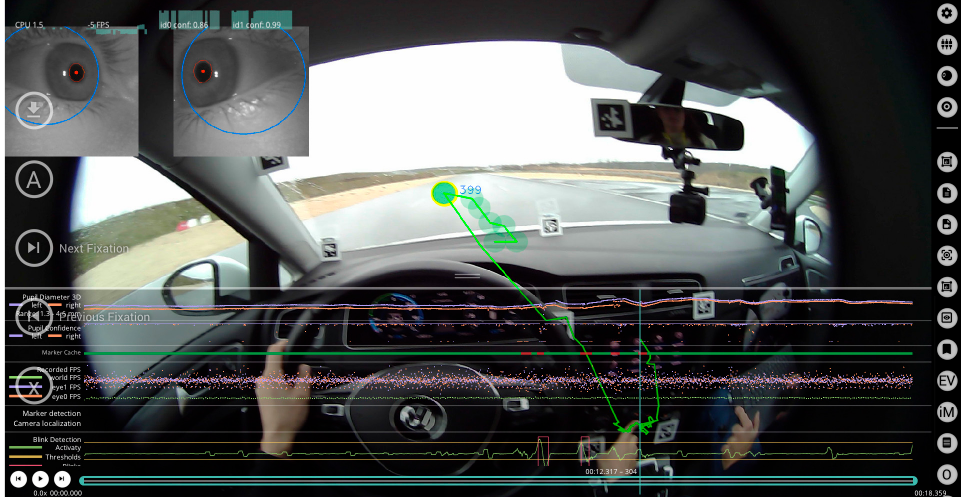
Figure 4. Gaze analysis with Pupil Player visualization.